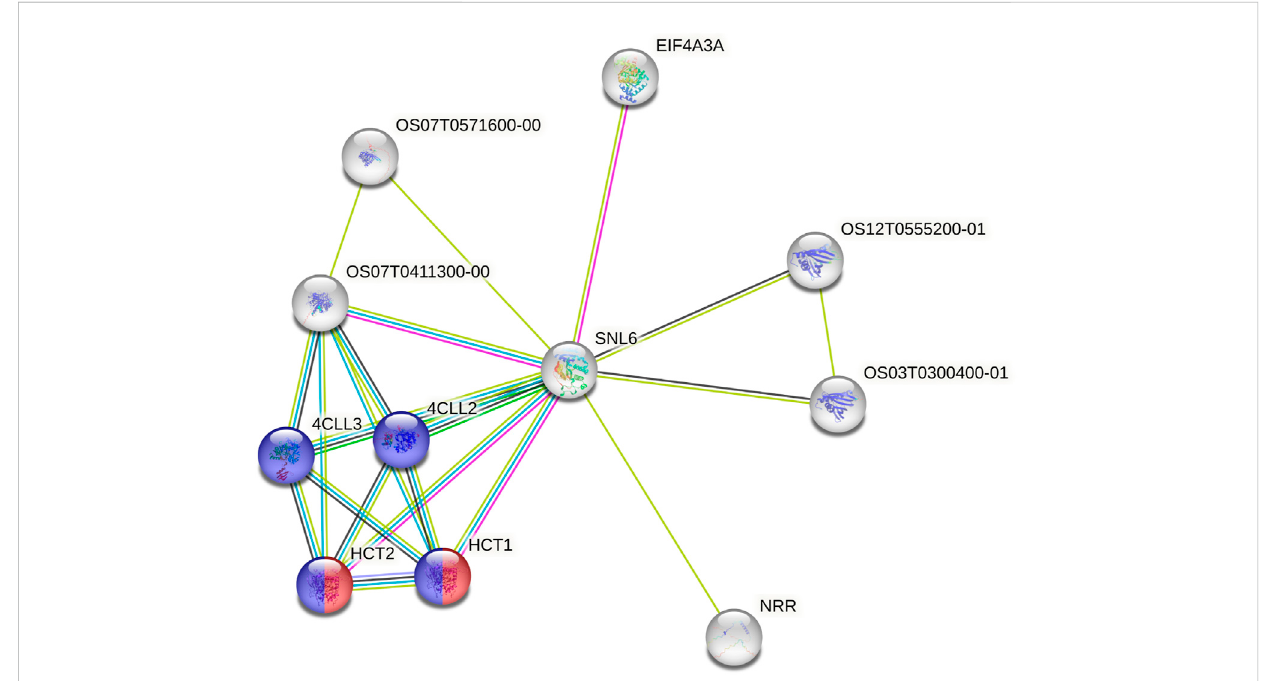
FIGURE 9 Protein-Protein Interaction Network for the rice ortholog (SNL6) of the R locus gene Sobic.003G233200. Interaction types were represented by different colored edges between nodes that represent genes. Functional KEGG pathways involved in fl avonoid (red) and phenylpropanoid (blue) biosynthesis are highlighted. Network results were generated using the String protein-protein interaction database (Szklarczyk et al.,